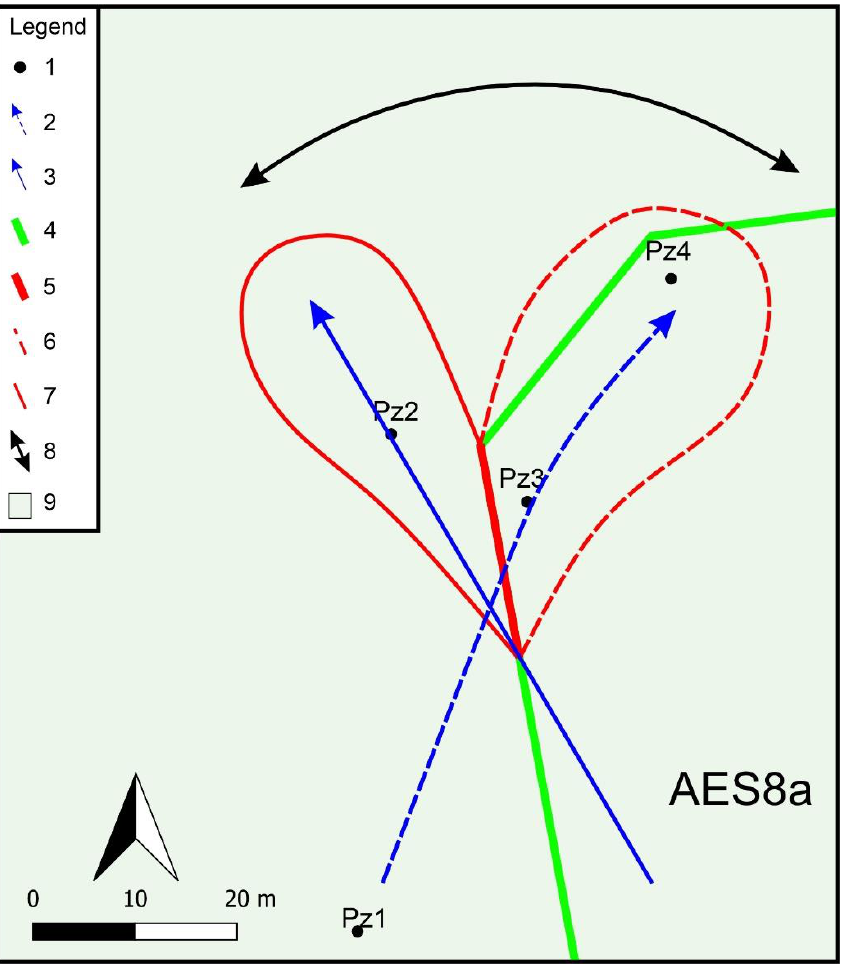
Figure 11. Conceptual oscillation of a contamination plume over time that is due to variation in the groundwater flow direction: (1) piezometer; (2) groundwater flow direction in May 2022; (3) groundwater flow direction in October 2022; (4) sewerage; (5) conceptual leaks; (6) conceptual plume theoretically linked to the groundwater flow direction in May 2022; (7) conceptual plume theoretically linked to the groundwater flow direction in October 2022; (8) variation of groundwater flow direction over time; (9) outcropping geological unit (AES8a).